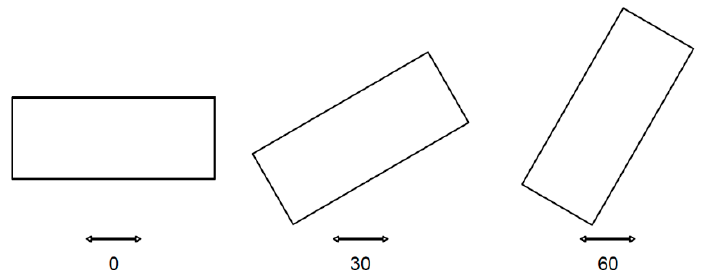
Figure 2. Tank orientations for simulations.